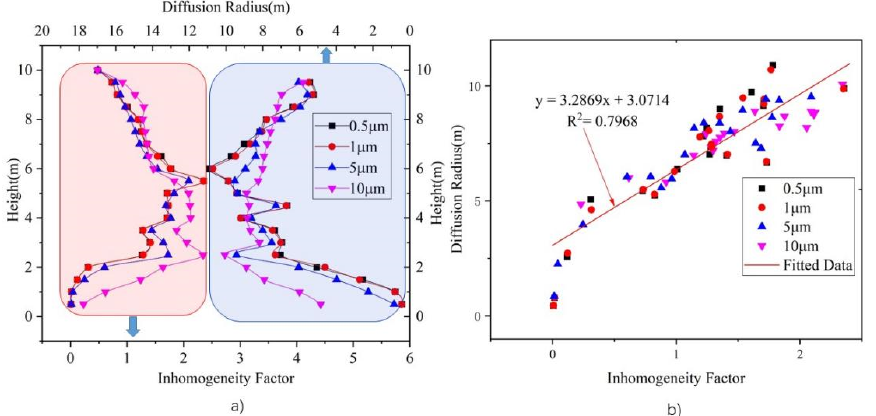
Figure 16. Relationship between vertical average inhomogeneity factor and horizontal plane diffu- sion radius. ( a ) Comparison of inhomogeneity factor with plane diffusion radius, and ( b ) correlation between inhomogeneity factor and horizontal plane diffusion radius.